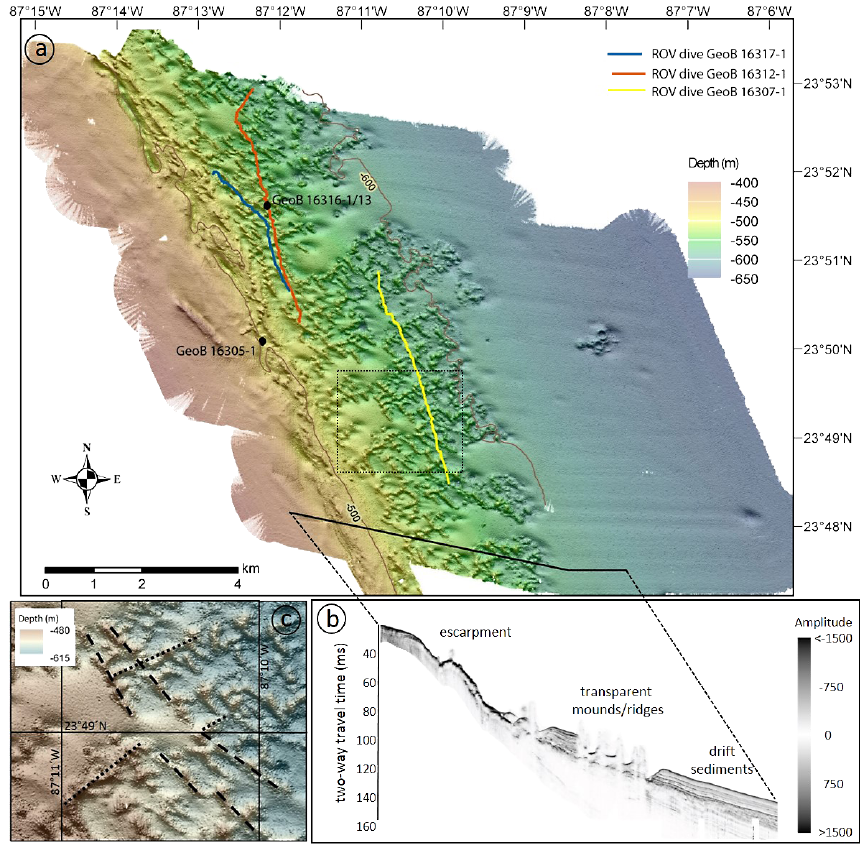
Fig. 2. Overview on the Campeche cold-water coral province (for location see Fig. 1). (a) Detailed bathymetric map showing the eastern margin of the Campeche Bank comprising the Campeche cold-water coral province revealing numerous individual elongated coral mounds located mainly between 500 and 600m water depth. Indicated are CTD sites (black dots) and ROV dive tracks (colored lines; GeoB station numbers are indicated) conducted during R/V Maria S. Merian cruise MSM 20-4 (for detailed site information see Table 1). (b) PARA- SOUND profile crossing the slope and highlighting the main morphological units. (c) High-resolution view on some of the elongated coral mounds (for position see dotted rectangle in a ), with the dominant northwesterly directions marked by dashed lines and with the sub-dominant northeasterly directions marked by the dotted